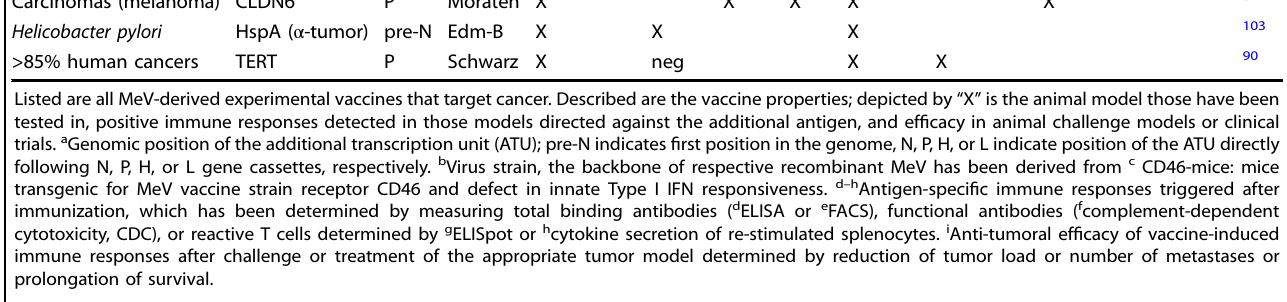
Table 5. Recombinant MeV-derived cancer vaccines.